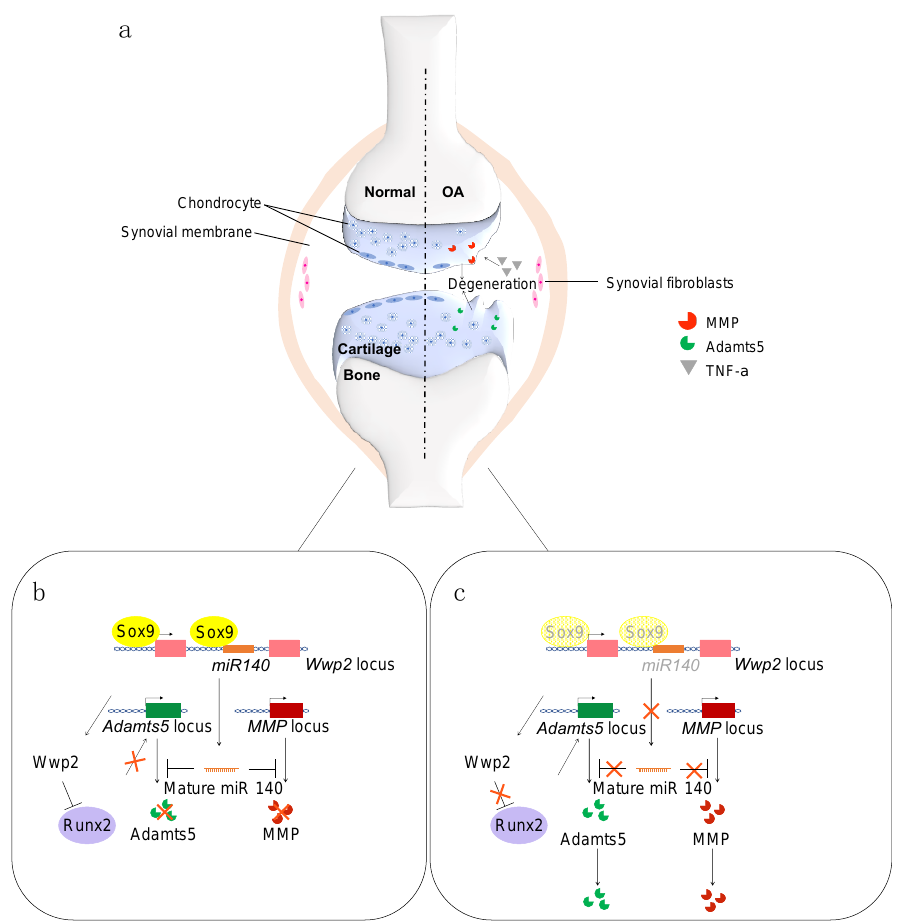
Figure 1. ( a ) Schematic representation of normal (left) and OA (right) cartilages. ( b ) Cartilage homeostasis is maintained by the Sox9 and miR-140 pathways. ( c ) In OA, the expression levels of Sox9 and miR-140 are